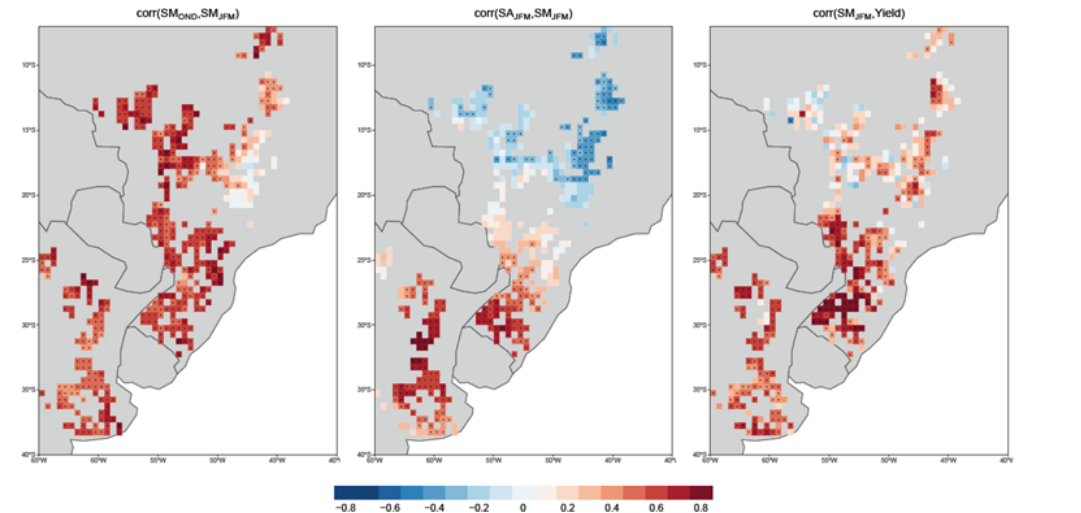
Figure A3. Grid-based correlation maps for crop yields, the SA pattern and antecedent (austral spring – OND) soil moisture against summer soil moisture (austral summer – JFM).